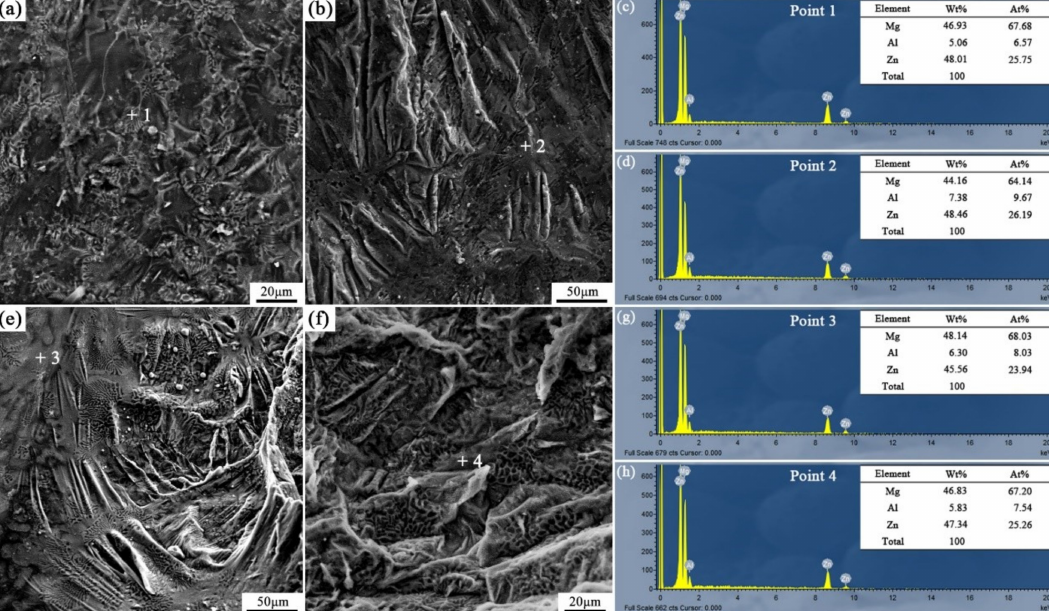
Figure 16. Fracture analysis of the arc-sprayed Al / AZ91D bimetals with a Zn interlayer: ( a , b ) SEM micrographs of S18H6 fracture surfaces, ( c , d ) EDS point scan spectra of points “1” and “2”, ( e , f ) SEM micrographs of S18H12 fracture surfaces, ( g , h ) EDS point scan spectra of points “3” and